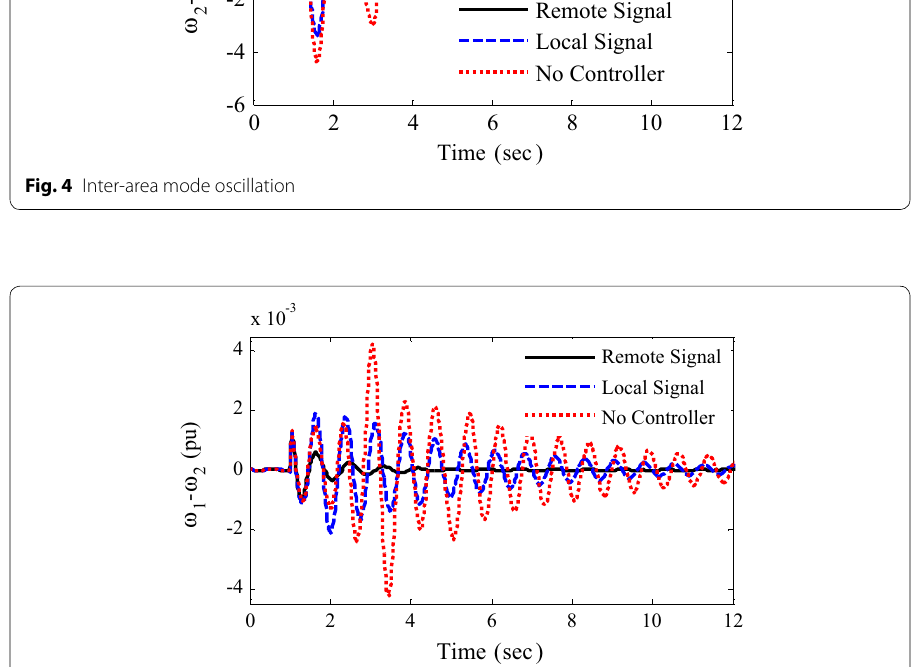
Fig. 5 Local mode